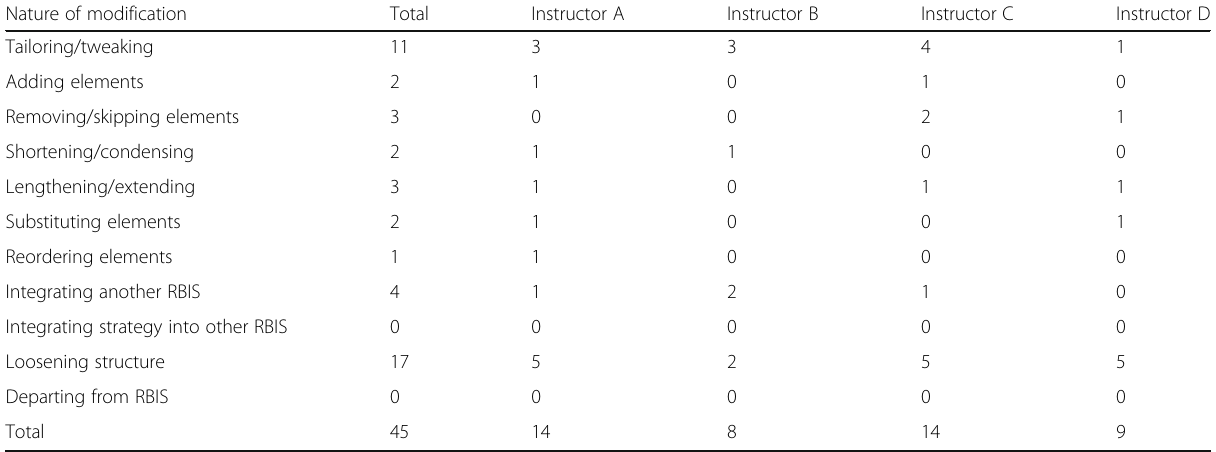
Table 7 Nature of modification